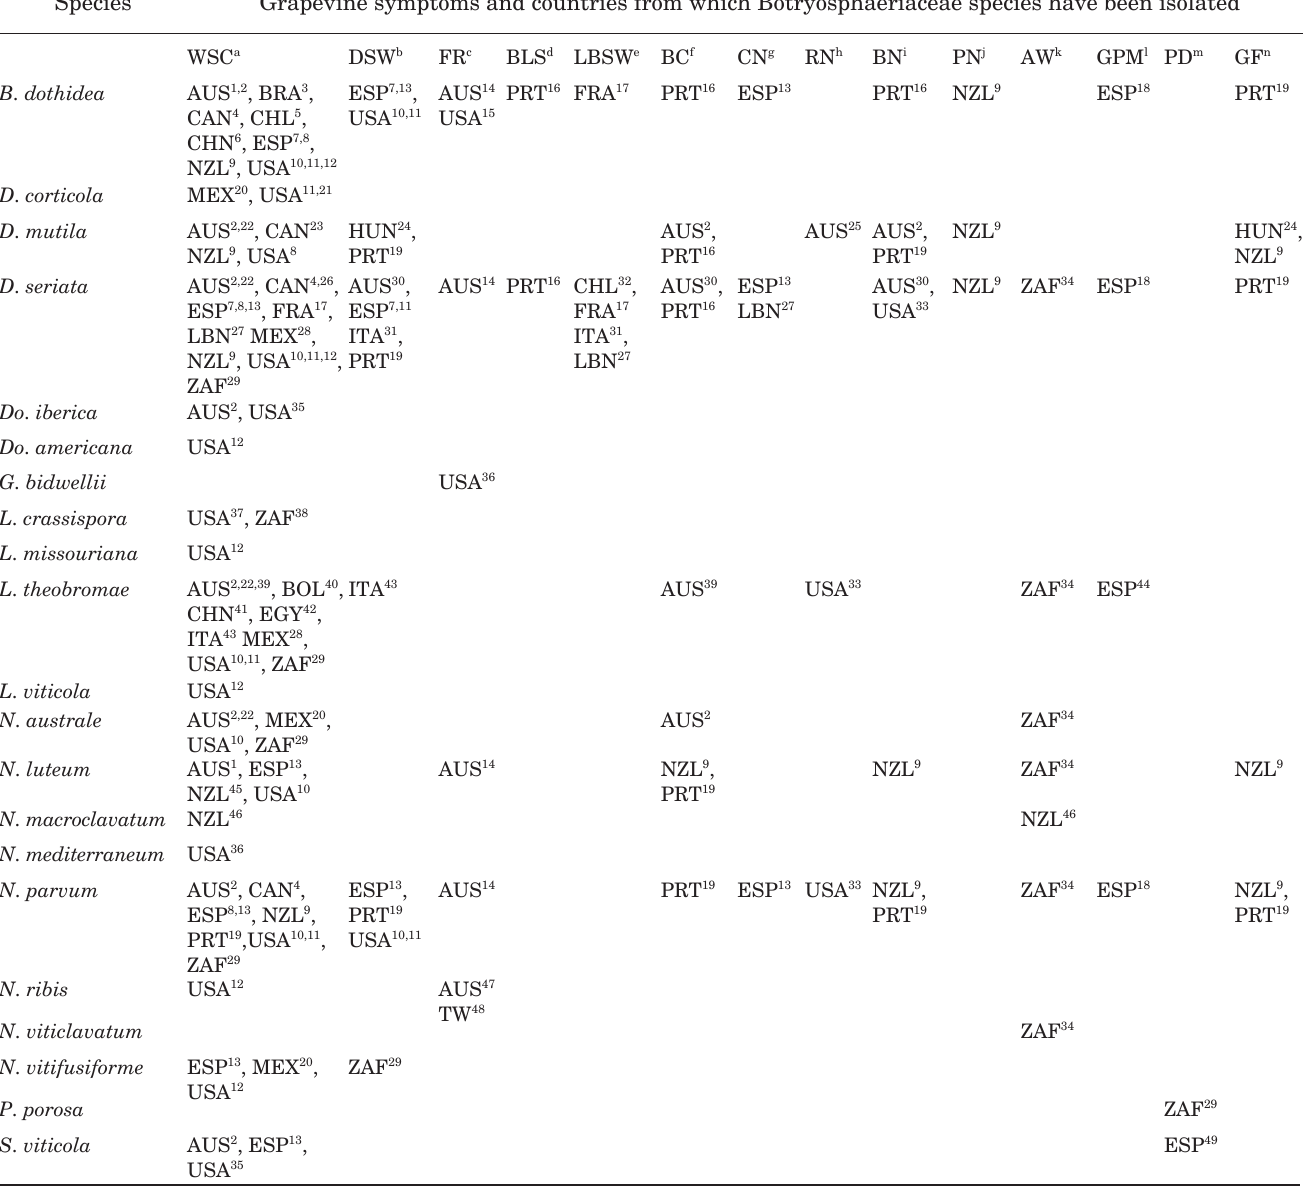
Table 2. Grapevine symptoms from which Botryosphaeriaceae species have been isolated in different grape-growing regions worldwide. Species Grapevine symptoms and countries from which Botryosphaeriaceae species have been